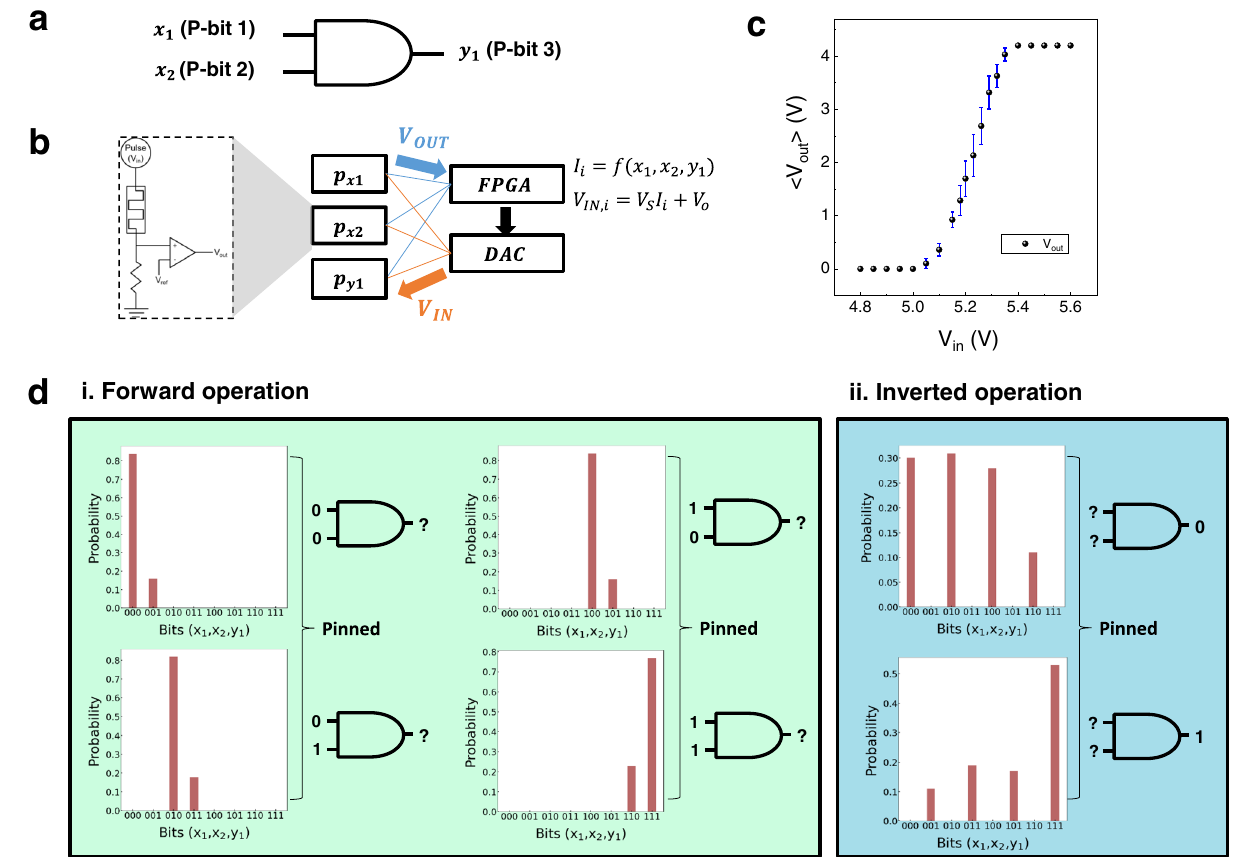
Fig.3|Booleanlogicoperationthroughthememristor-basedp-computing.a A schematicAND gate using three p-bits. b Hardware implementationusing anFPGA and three p-bits. c Distributions of the memristor-based p-bit at different input